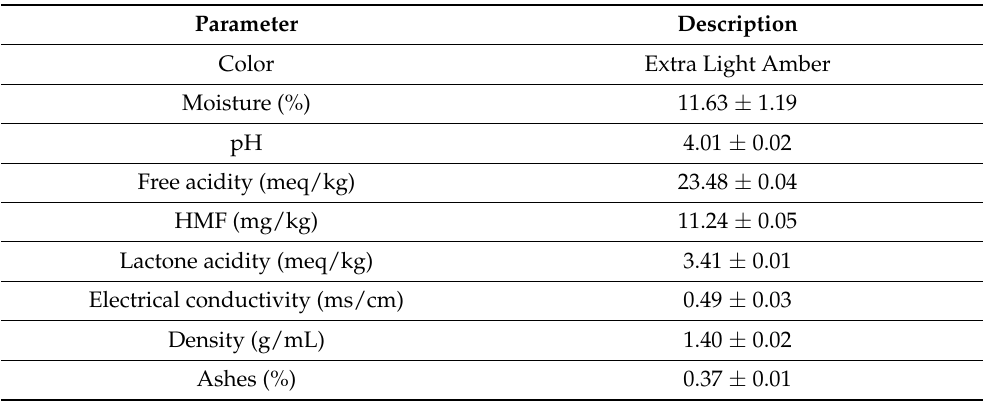
Table 1. Physicochemical characteristics of E. globulus